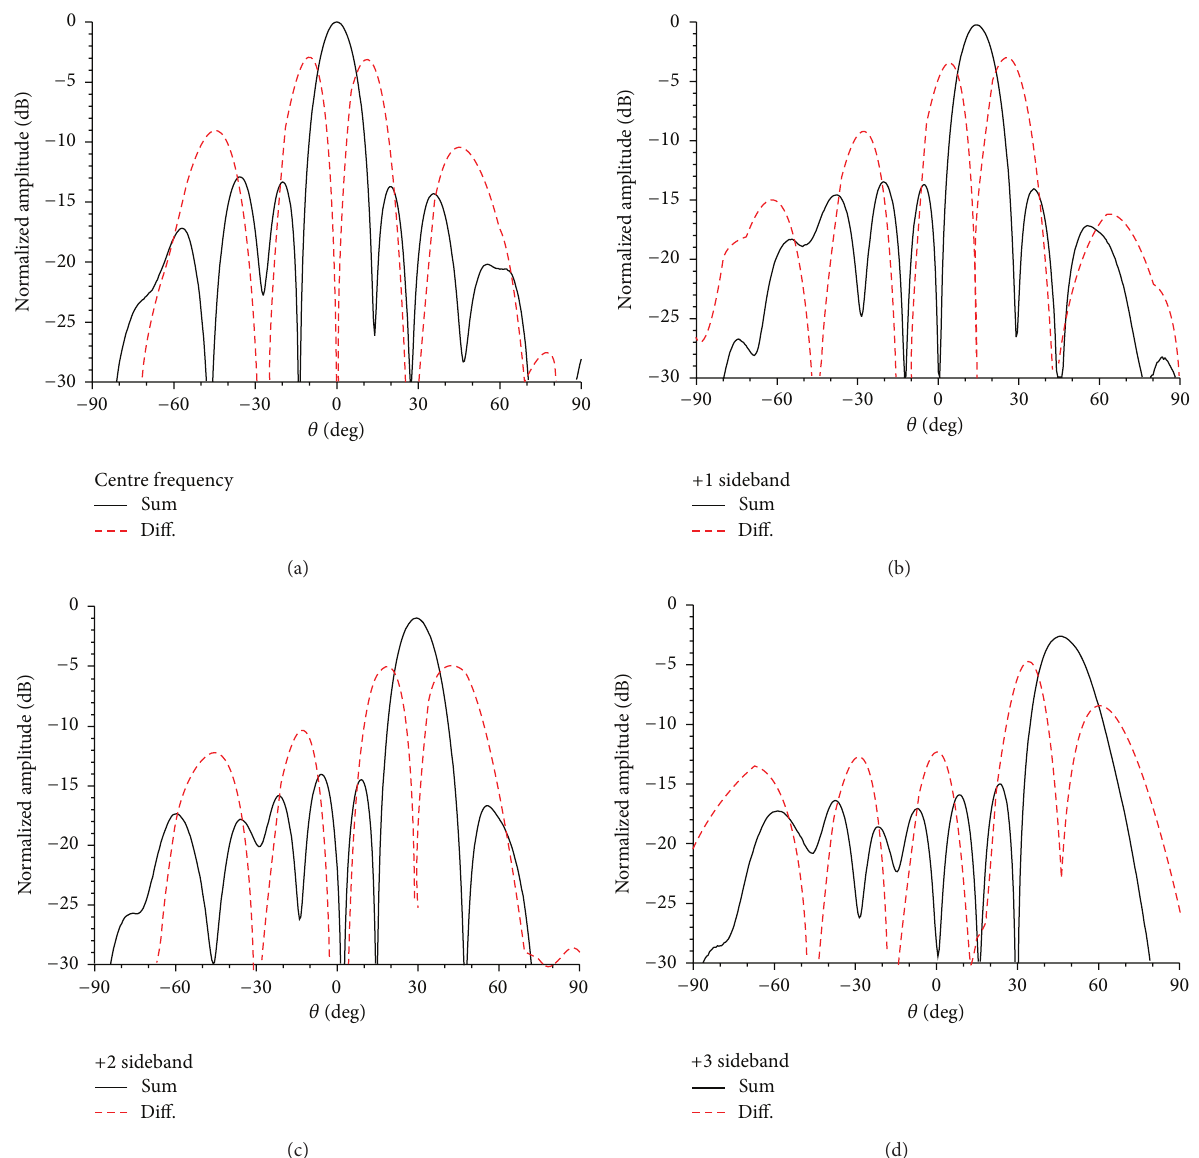
Figure 11: Sum-difference patterns taking into account the measured active element